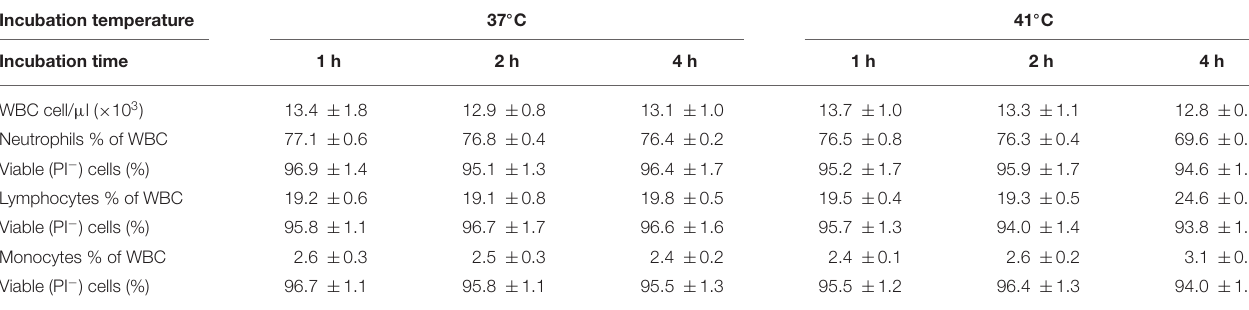
TABLE 1 | The impact of heat treatment on leukocyte count, their differential composition, and the percentage of viable (non-necrotic) cells. Incubation